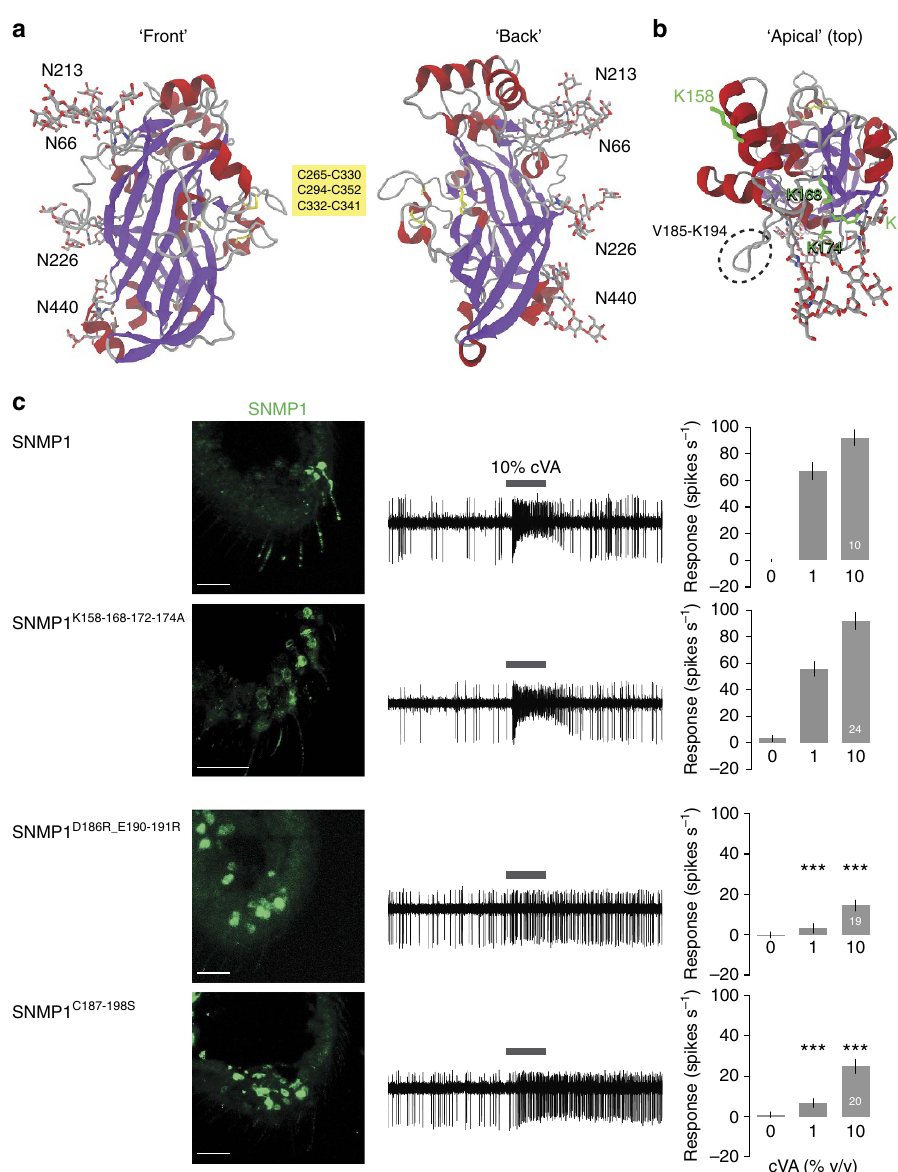
Figure 7 | An SNMP1 protein homology model. ( a ) Protein homology model of the SNMP1 ectodomain, from two different views. The a -helices and b -strands are shown in ribbon format in red and purple, respectively. Putative glycosylation sites, cysteine residues and disulfide bonds are indicated in stick format and coloured according to their elements (C: silver, N: blue, O: red, S: yellow). ( b ) ‘Apical’ (top) view of the SNMP1 ectodomain. The side chains of K158, K168, K172 and K174 are represented in stick format (green). The SNMP1-specific loop is highlighted with a dashed black circle. ( c ) Analysis of the rescue properties of SNMP1 site-directed mutants lacking the apical basic residues (SNMP1 K158-168-172-174A ) or with substitutions in the SNMP1-specific loop (SNMP1 D186R_E190-191R and SNMP1 C187_198S ). Left: immunostaining with a -SNMP1 on antennal cryosections. Scale bars, 20 m m. Centre: representative traces of electrophysiological recordings of OR67d neurons in male flies stimulated with 10% cVA. Right: mean neuronal responses ± s.e.m. in each genotype. There are significant statistical differences in neuronal responses due to genotype for both 1 and 10% cVA (Kruskal–Wallis, P o 0.0001). Significant differences in cVA responses of the different genotypes compared with full-length SNMP1 rescue are indicated in the figure; *** P o